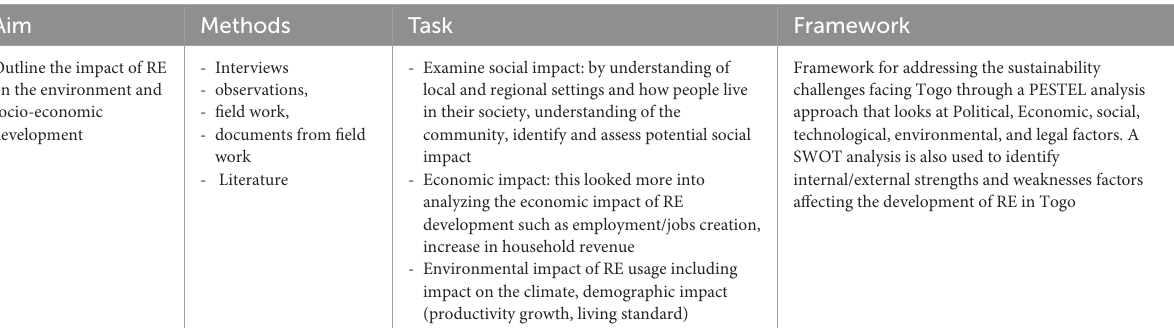
TABLE 1 Summary of the process used for impact